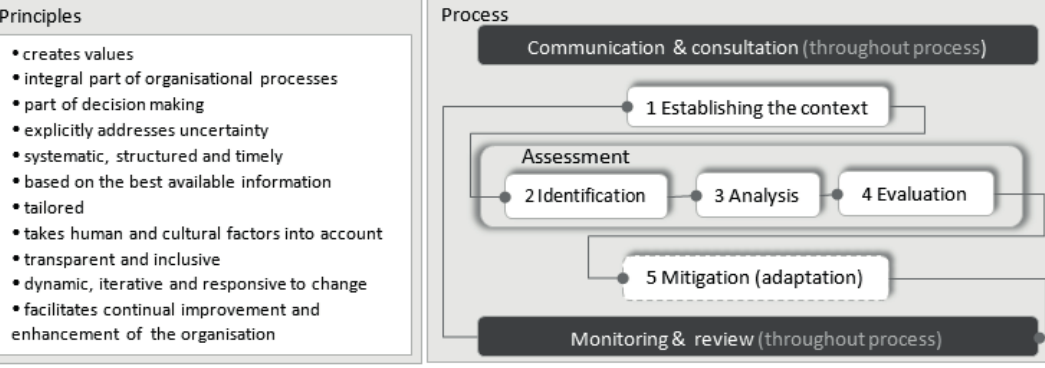
Fig. 1 The 11 principles and process steps in the ISO 31000:2009 risk management standard. Note the inclusion of stakeholders (through communication and consultation, and monitoring and review) throughout all stages of the process. Note that the feedback loops inherent in being “dynamic, iterative and response to change” are not included in this figure to provide clarity. Adapted from Standards Australia